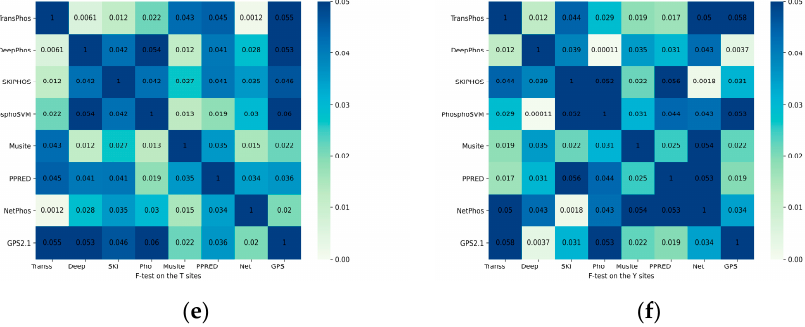
Figure 2. Heat map of the significance F-test, the value of each square in the graph is the p -value of the statistical test, and it is generally accepted that a p -value less than 0.05 means that the 2 statistics are significantly different. Here we use scientific notation, for example 1.6e-14 means 1.6 × 10 − 14 . All statistical tests were performed on the predicted results of the test dataset PPA. In the horizontal coordinates, the names of some models are abbreviated to show them in full. ( a ) Significance F-test of the prediction results between the deep learning models for the S sites. ( b ) Significance F-test of the prediction results between the deep learning models for the T sites. ( c ) Significance F-test of the prediction results between the deep learning models for the Y sites. ( d ) Significance F-test of the prediction results for the S sites between other prediction models. ( e ) Significance F-test of the prediction results for the T sites between other prediction models. ( f ) Significance F-test of the prediction results for the Y sites between other prediction models.